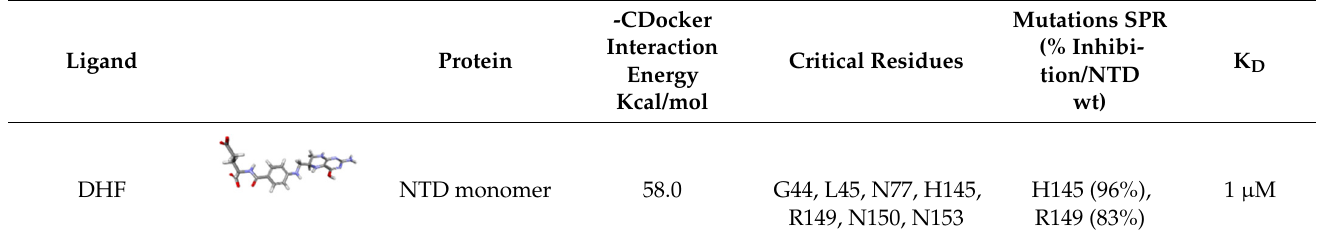
Table 2. Summary of the ligand-N interactions obtained by modeling compared to the measured complex by surface plasmon resonance with wt or mutant NTD or wt FL.